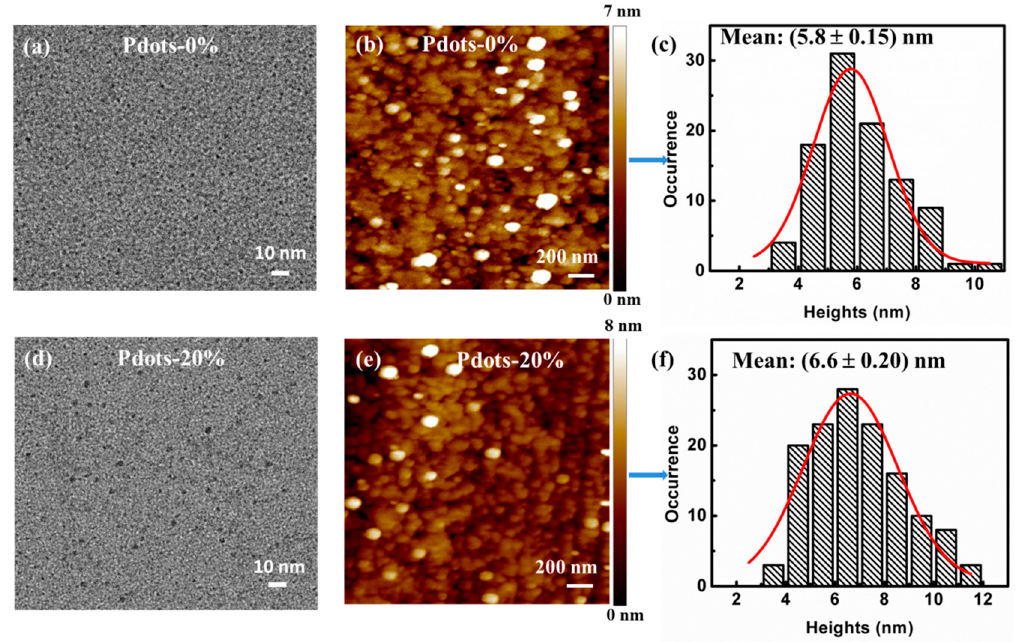
Sensors 2019 , 19 , x FOR PEER REVIEW Figure 2. TEM image, AFM topography and the corresponding histogram of height of Pdots doped with different BDMO-PPV contents: ( a – c ) Pdots- 0%; ( d – f ) Pdots-20%.